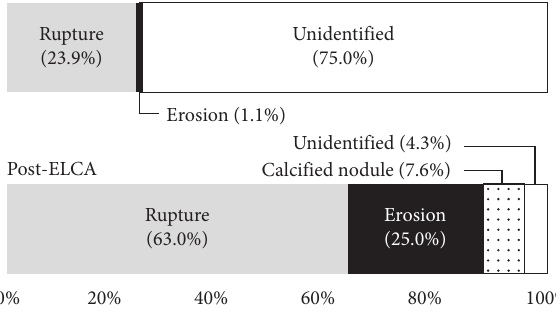
Figure 3: OCT identification of lesion morphology after MT and ELCA. Lesion morphology was not identifiable in the majority of cases even after MT because of the residual thrombus occupying the lumen. Vaporization of the thrombus by ELCA facilitated the identification of plaque morphology using OCT. OCT, optical and ELCA, excimer laser coronary